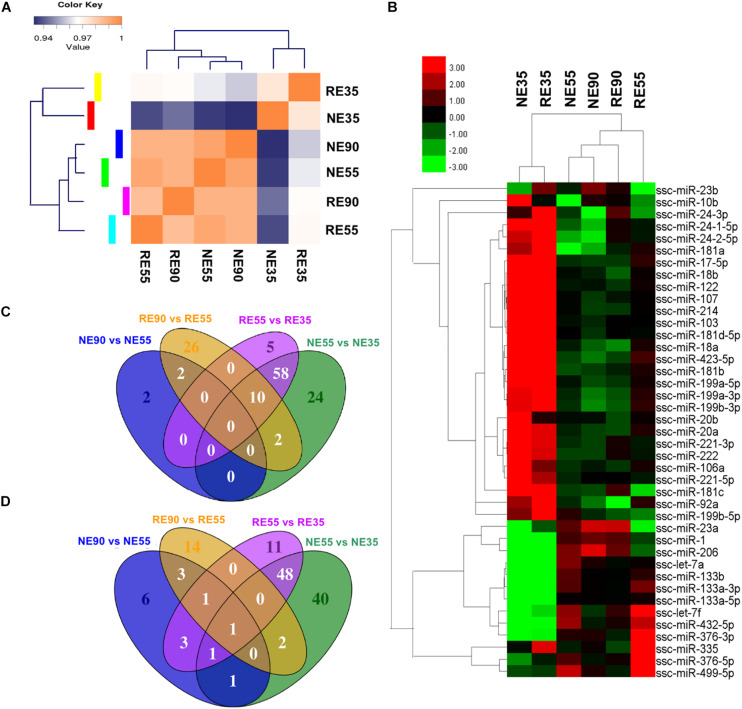
Nutrient-regulated miRNA expression pattern during prenatal muscle development. (A) Sample correlation matrix indicates a critical role of MCR in miRNA expression. (B) Heatmap shows the influence of MCR on expression profiling of muscle-specific miRNAs. (C,D) Venn diagrams show the overlap among DE miRNAs identified in various comparisons [(C) shows the upregulated miRNAs, (D) shows the downregulated miRNAs]. NE35, NE55, and NE90 indicate samples collected from NE group at 35, 55, and 90 dg, respectively, RE35, RE55, and RE90 indicate samples collected from RE group at 35, 55, and 90 dg,